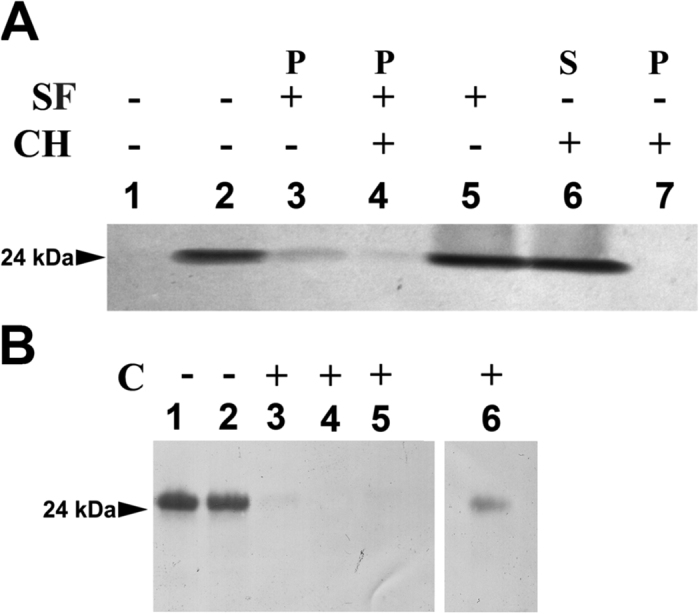
Thylakoid membrane fractions after insertion of spinach apocytochrome b6 and treatment with chaotropic agents (CH).(A) The integration of the cytochrome b6 into the thylakoid membrane in the presence or absence of stromal fraction (SF) was analysed with Western blot. Lane 1, thylakoid membrane; lane 2, purified apocytochrome b6; lane 3 pelleted membrane fraction with inserted denatured (unfolded) protein; lane 4, pelleted membrane fraction with inserted denatured protein after chaotropic treatment with urea; lane 5, control, membrane fraction with inserted into membrane ss-apocytochrome b6; lanes 6 and 7, supernatant and membrane pellet, respectively after centrifugation of refolded apocytochrome b6 and inserted into membrane. The experiments were repeated twice and 10 μg of total protein per lane was applied. (B) Thylakoid membrane fractions after insertion of spinach ss-apocytochrome b6 and treatment with carboxypeptidase B. Lane 1, purified ss-apocytochrome b6; lane 2, thylakoid membrane with inserted ss-apocytochrome b6; lane 3, membrane treated with carboxypeptidase B (depicted with (C) after protein insertion; lanes 4 and 5, membrane and supernatant fraction with inserted denatured protein after carboxypeptidase B treatment; lane 6, supernatant fraction similar to lane 5, but membrane with inserted denatured protein was treated with urea and carboxypeptidase B, and an antibody against N-terminus of cytochrome b6 was used. Cytochrome b6 was biotin labelled and anti-biotin antibodies were used for detection with the exception of (B) line 6.